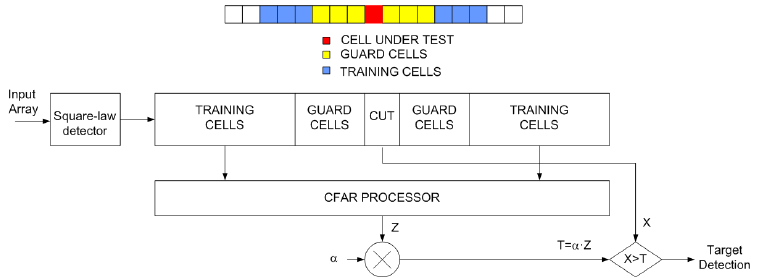
Figure 12. Block diagram of the CFAR